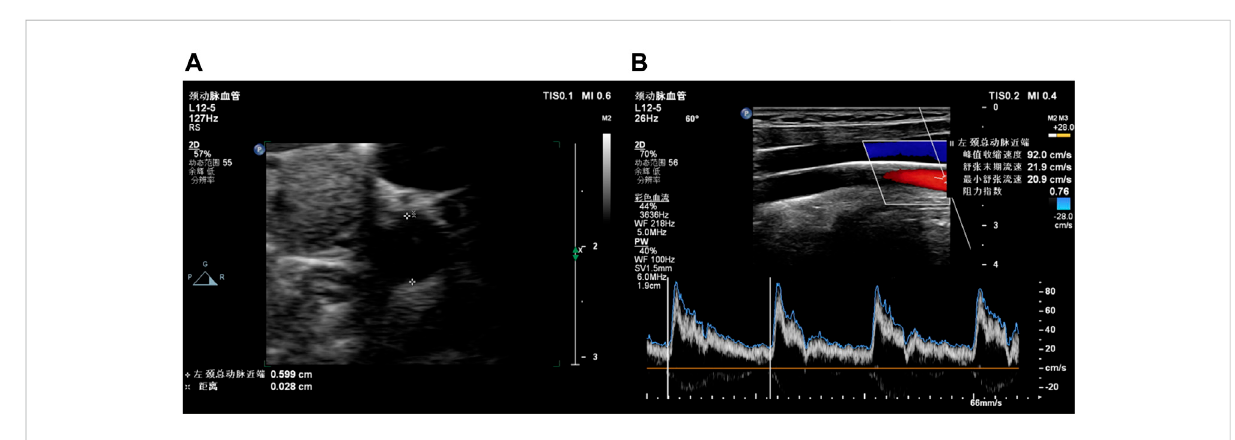
FIGURE 1 Process of ECG signals collecting and CUS